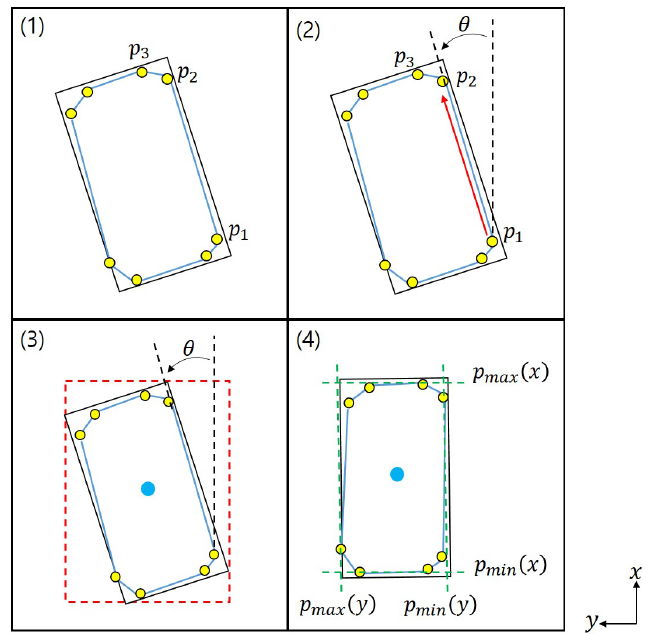
Figure 5. The method for determining the orientation of a plane through a rectangle with minimum area. ( 1 ) Points constituting the convex hull; ( 2 ) Angle calculated from points; ( 3 ) Axis-aligned bounding box; ( 4 ) Bounding box with minimum